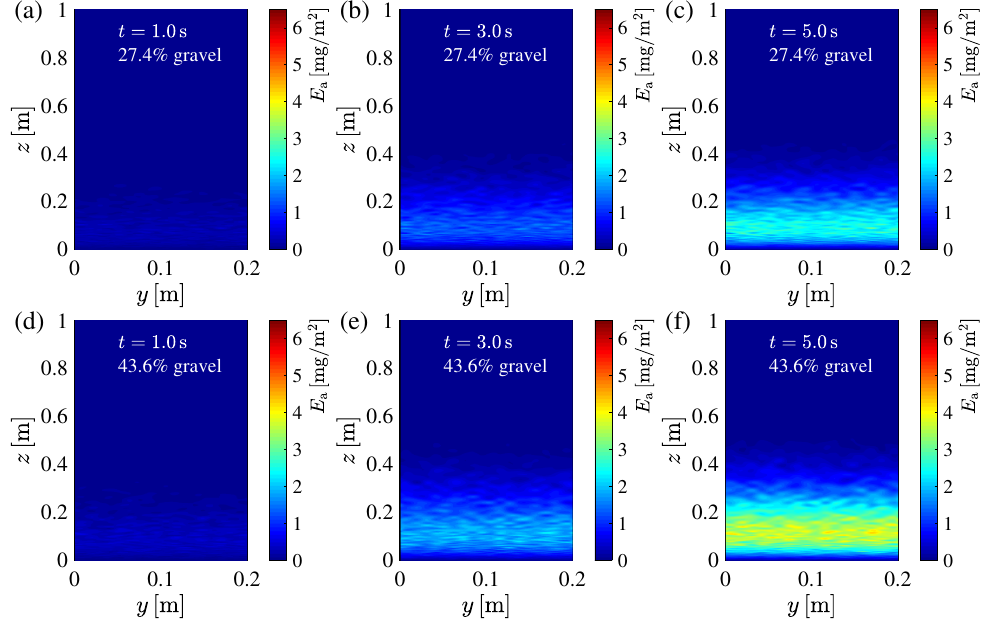
Figure 5. Spatial distribution images of impact erosion amount E a [ mg/m 2 ] in sand drift at u ∗ = 0.60m/s, for ( a – c ) on Gobi with 27.4 gravel coverage and ( d – f ) on Gobi with 43.6% gravel